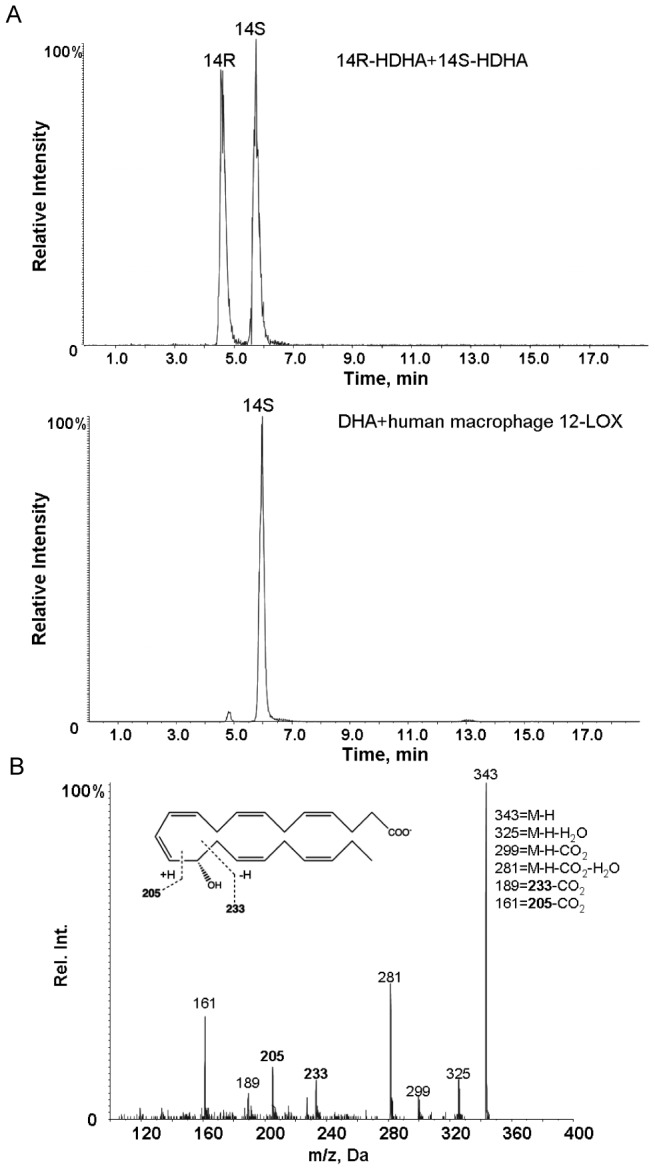
Human macrophage 12-LOX produces 14S-HpDHA.(A) Chiral chromatography of synthetic 14R-HDHA and 14S-HDHA (upper panel). DHA (5 µM) was incubated with human macrophage 12-LOX (0.2 µM, 10 min, 37°C, pH 8). Products were extracted (see methods for details) and subject to chiral high performance liquid chromatography-tandem mass spectrometry (m/z, 343>205) (lower panel). (B) MS-MS spectrum of 14S-HDHA from human macrophage 12-LOX incubations (lower panel in A).